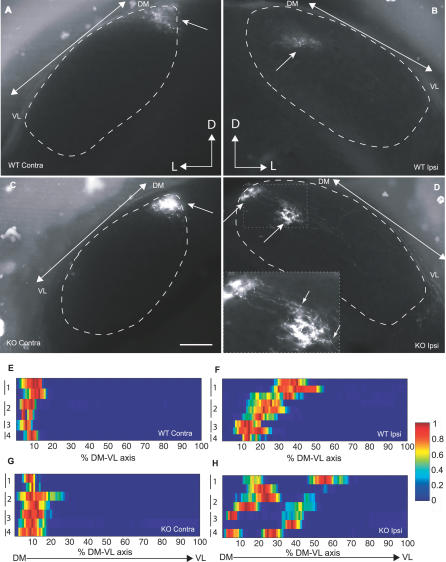
Focal Ipsilateral Terminations Are Altered in Ten_m3 KO Mice(A–D) Contralateral (A) and (C) and ipsilateral (B) and (D) coronal sections through the dLGN of WT (A) and (B) and Ten_m3 KO (C) and (D) mice following focal injections of DiI into the peripheral ventrotemporal retina. Injections were of a similar size in WTs and KOs, and resulted in a single TZ near the dorsomedial (DM) border of the contralateral dLGN in both groups of animals (arrows in [A] and [C]). Labelling in the ipsilateral dLGN from these same injections shows a different pattern in WTs (B) versus KOs (D). In WT mice, a single patch of label is in a location similar to the position of the ipsilateral patch following bulk injections in WTs (arrow in [B]; compare to Figure 3B). In the Ten_m3 KO mice, there are two distinct foci, one abutting the dorsomedial border of the dLGN and the other more ventrolateral (arrows in [D]). A higher power view of the region indicated in the dotted box is shown in the inset: a number of axons can be seen to pass directly from one TZ to the other rather than enter the more dorsomedial TZ from the optic tract. In addition, axons appear to bifurcate near the more ventrolateral TZ (small arrows) and send branches towards each TZ. The borders of the dLGN are marked with the dashed line. The arrow indicates the DM-VL axis along which the distribution of label was quantified. D, dorsal; L, lateral; M, medial.(E–H) Heat maps showing the complete distribution of terminal label in all labelled sections through contralateral (E) and (G) and ipsilateral (F) and (H) dLGN from four WT (E) and (F) and four KO mice (G) and (H). Each horizontal line represents a section. In some mice, label was observed in more than one section; sections taken from the same animal are grouped by a vertical line on the left-hand side of each heat map. Each animal is numbered. The x-axis plots percent distance along the DM-VL axis of the dLGN as defined above. In contralateral sections, label was always confined to the DM region of the dLGN and appears similar between WTs and KOs. A single patch of ipsilateral label is seen in ipsilateral sections from WTs. Comparison of the position of the label across sections from a given animal indicates that these correspond to a single TZ. Two distinct patches of label are seen in virtually every labelled ipsilateral section from KOs. Scale bar in (C) indicates 100 μm, and applies to all micrographs except the inset of (D), where it represents 50 μm.